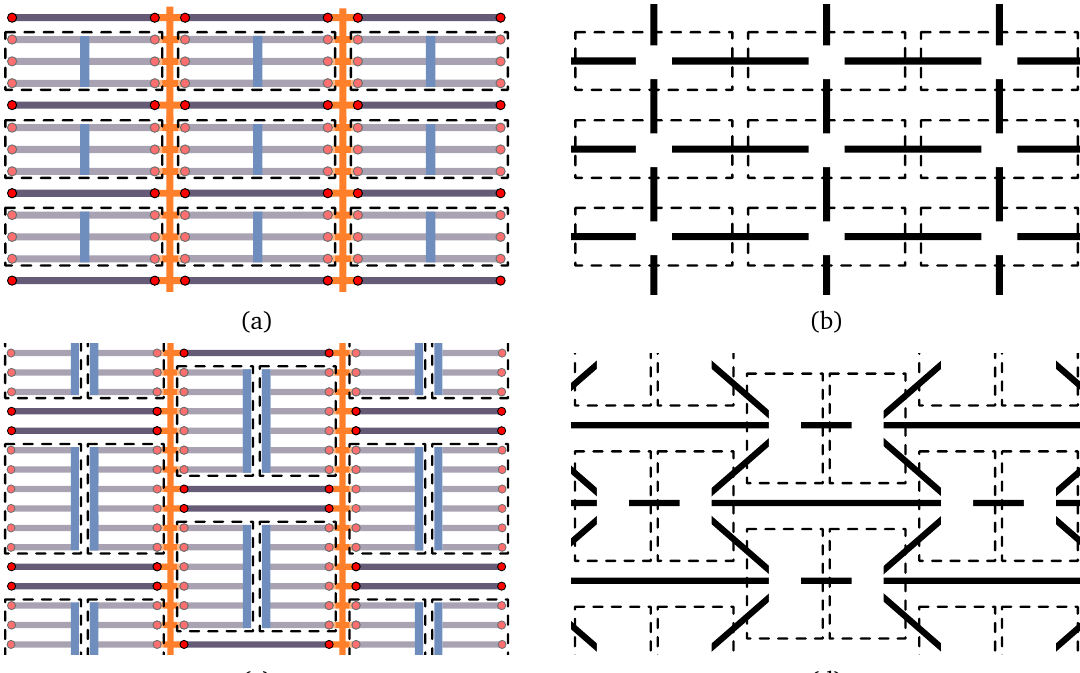
Figure 2: Arrays of hexons, where each hexon is shown enclosed in a dashed-line rectangle. (a) Two-sided hexons can be tiled regularly onto a rectangular lat- tice. (b) The connectivity of this two-sided hexon array, indicating which pairs of hexons can be acted on by joint 4 -MZM measurements, is shown by solid black lines connecting the dashed rectangles. (c) One-sided hexons can be tiled onto a squashed rectangular lattice, with left-facing on one sublattice and right-facing hexons on the other. (d) The connectivity of this one-sided hexon array, indi- cating which pairs of hexons can be acted on by joint 4 -MZM measurements, is shown by solid black lines connecting the dashed rectangles. Examples of mea- surements that yield the shown connectivity can be found in Figs. 3 and 4. In both architectures, the ability to physically implement two-qubit gates will not be equally difficult in the different directions. For example, utilizing coherent links will generally increase the